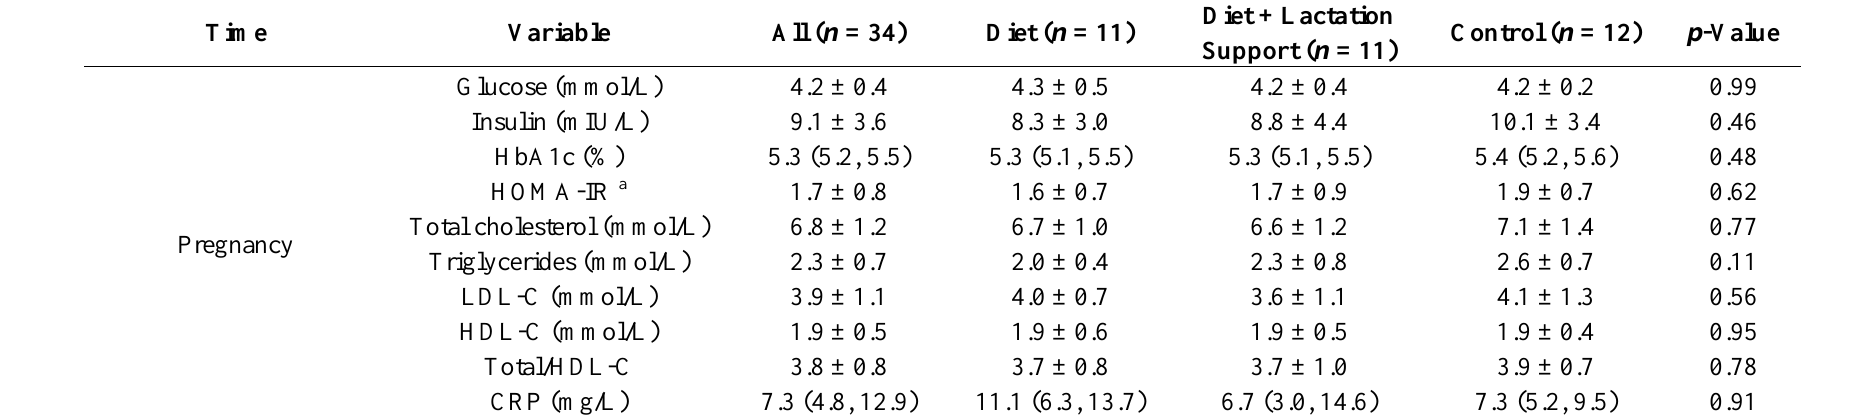
Table 3. Fasting biochemical data for pilot randomised controlled trial